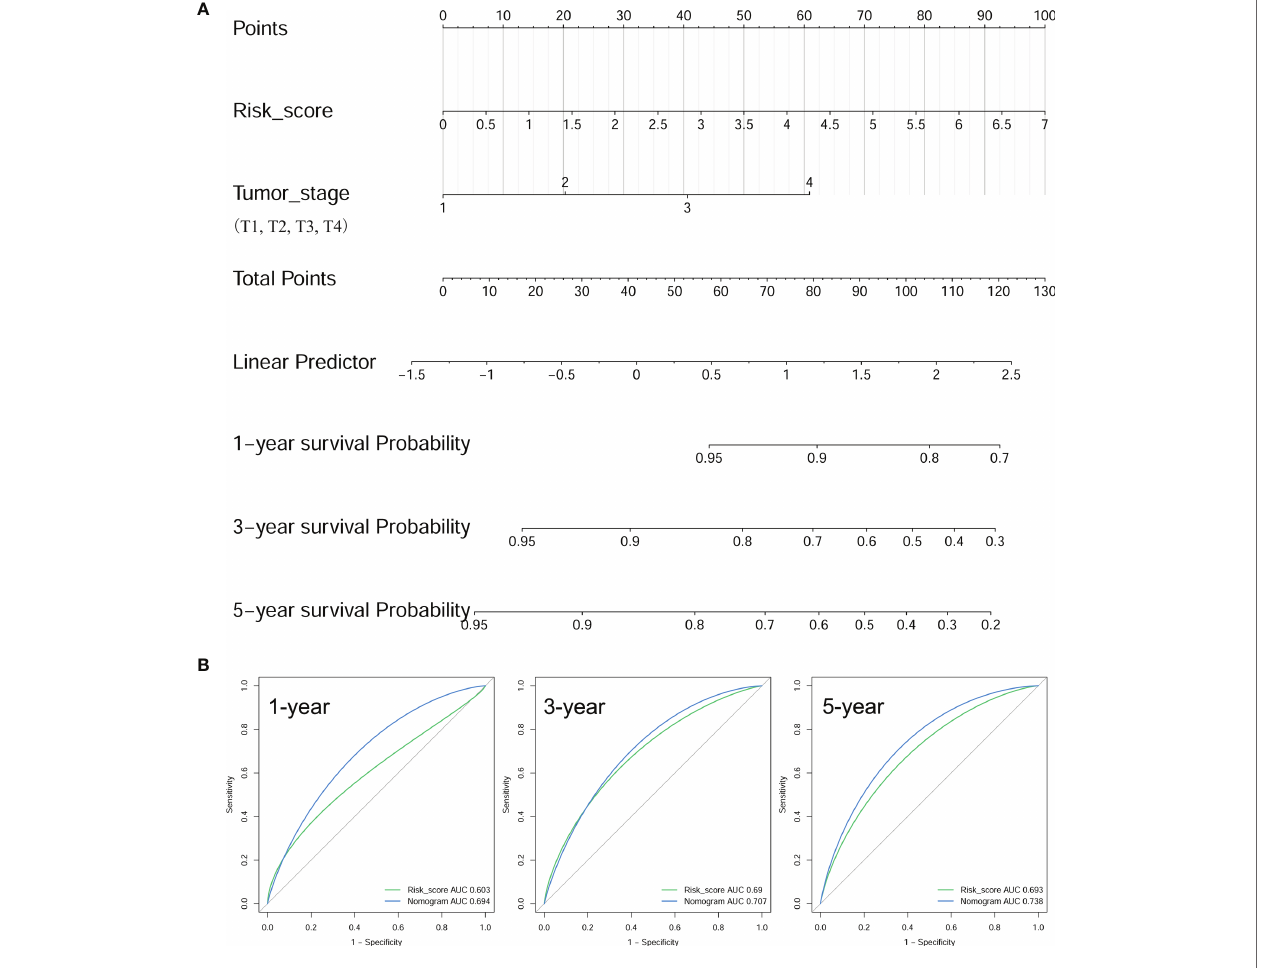
FIGURE 9 | Construction of a prognostic nomogram. (A) Nomogram to predict the 1-, 3-, and 5-year PFS of BRAF-mutated PTC based on risk score and tumor stage. (B) The tROCs for 1-, 3-, and 5-year PFS predictions for the nomogram and risk score. The tROC curve showed that the AUCs of the nomogram were higher at 1, 3 and 5 years (0.694, 0.707 and 0.738, respectively) than those of the risk score